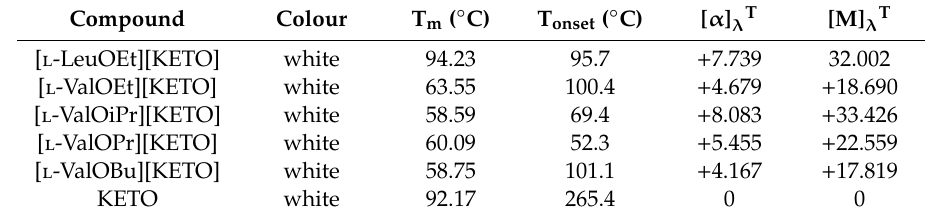
Table 1. The melting points and thermal stability of ketoprofen and its amino acid ester derivatives.